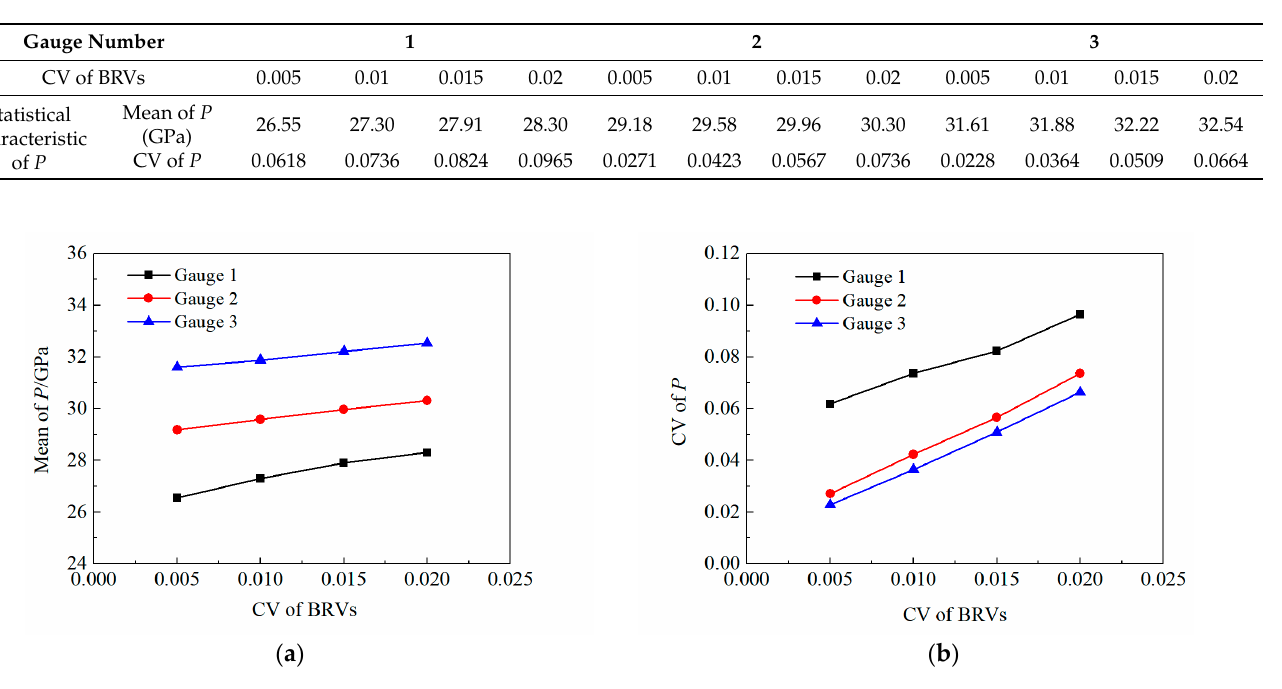
Figure 9. The correlation curves between the statistical characteristics of the P and the CVs of the BRVs under the shock load condition where v is 1050 m/s. ( a ) The correlation curves between the means of the P and the CVs of the BRVs. ( b ) The correlation curves between the CVs of the P and the CVs of the BRVs.